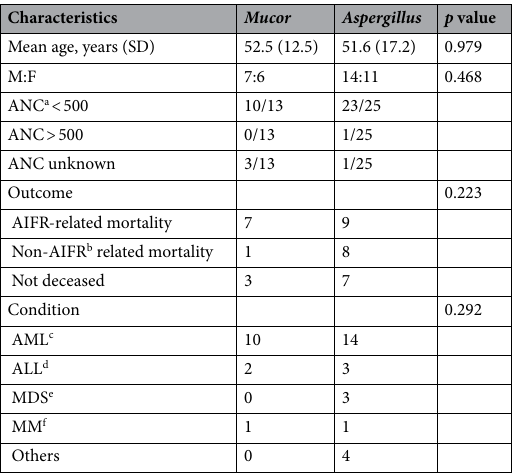
Table 1. Demographics and clinical characteristics of both patient groups. a ANC, absolute neutrophil count; b AIFR, acute invasive fungal rhinosinusitis; c AML, acute myeloid leukemia; d ALL, acute lymphocytic leukemia; e MDS, myelodysplastic syndrome; f MM, multiple